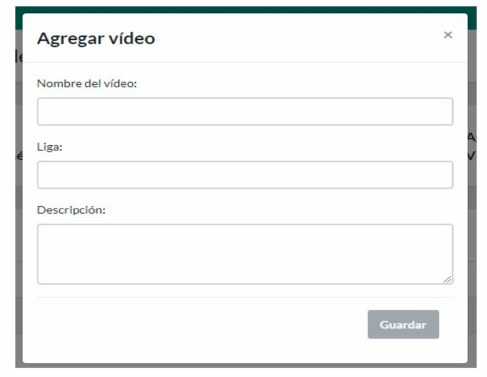
Figure 12. Administrator user interface: Service to add details and video links.